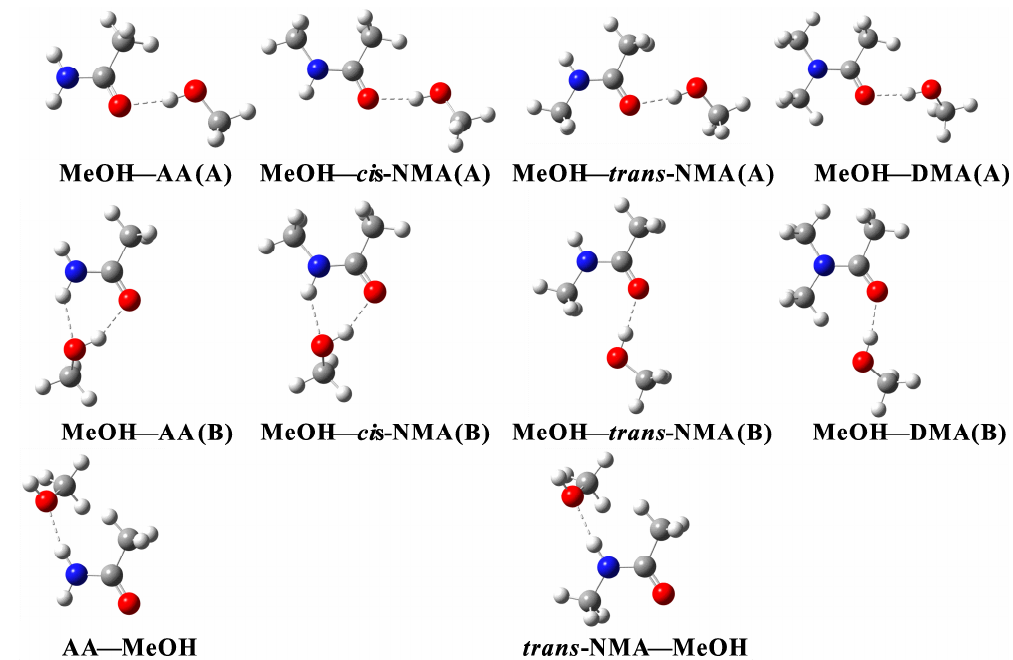
Figure 3. The stable structures of the MeOH–acetamide and acetamide–MeOH complexes obtained at the B3LYP-D3/aug-cc-pVTZ level; The O–H ··· O and N–H ··· O hydrogen bonds are presented by the dotted lines; AA: acetamide; NMA: N -methylacetamide; DMA: N , N -dimethylacetamide; MeOH: methanol.